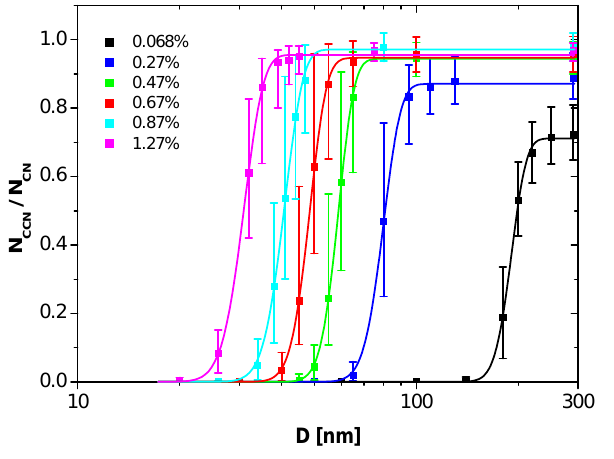
Fig. 3. CCN efficiency spectra at S =0.068%–1.27% averaged over the entire campaign. The data points are median values calculated from the CDF fits to all measured spectra at the particle diameters initially selected with the DMA (20–290nm). The error bars extend from the lower to the upper quartile, and the lines are 3-parameter CDF fits to the data points (Sect. 2.2.4).